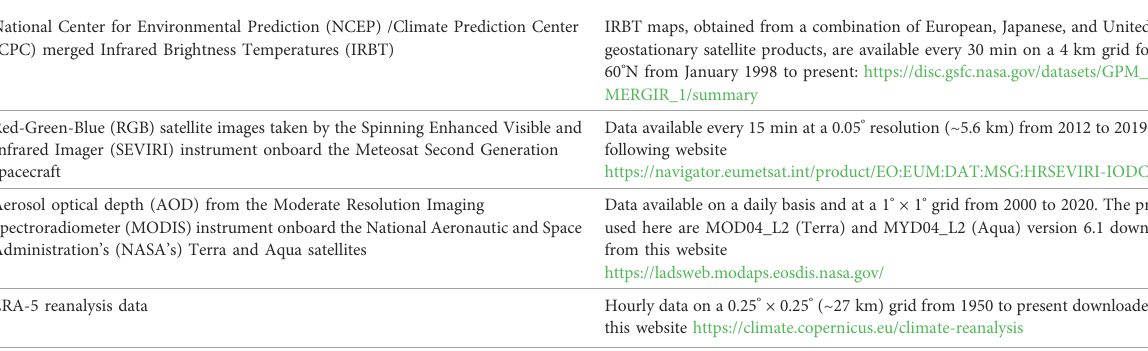
TABLE 1 List of the satellite-derived and reanalysis products used in this work. Dataset